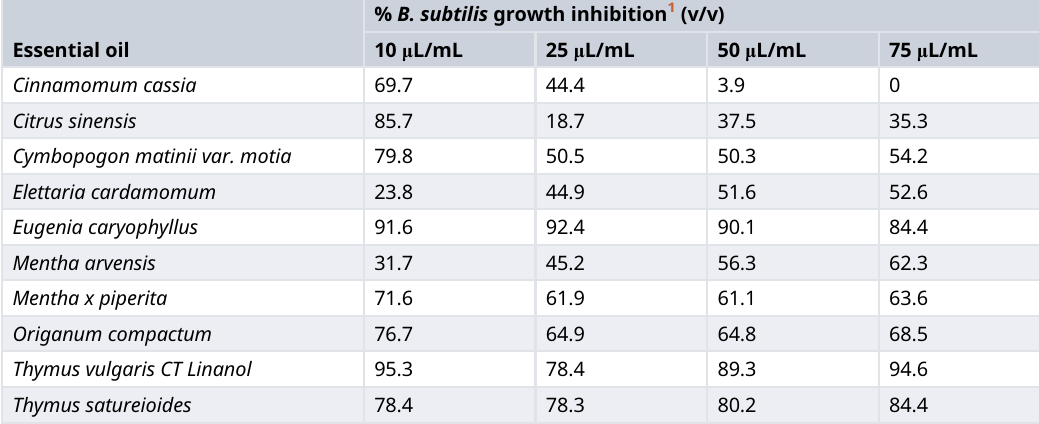
Table 4. Minimum Inhibitory Concentration (MIC) values of some essential oils against B.